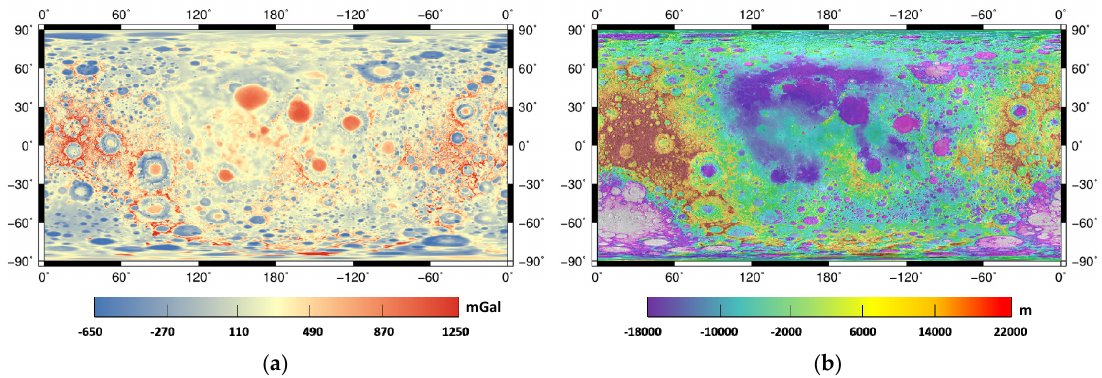
Figure 3. Lunar gravity data and DEM product. ( a ) Gravity Recovery and Interior Laboratory (GRAIL) 800 degree; ( b ) The global DEM product of Moon.